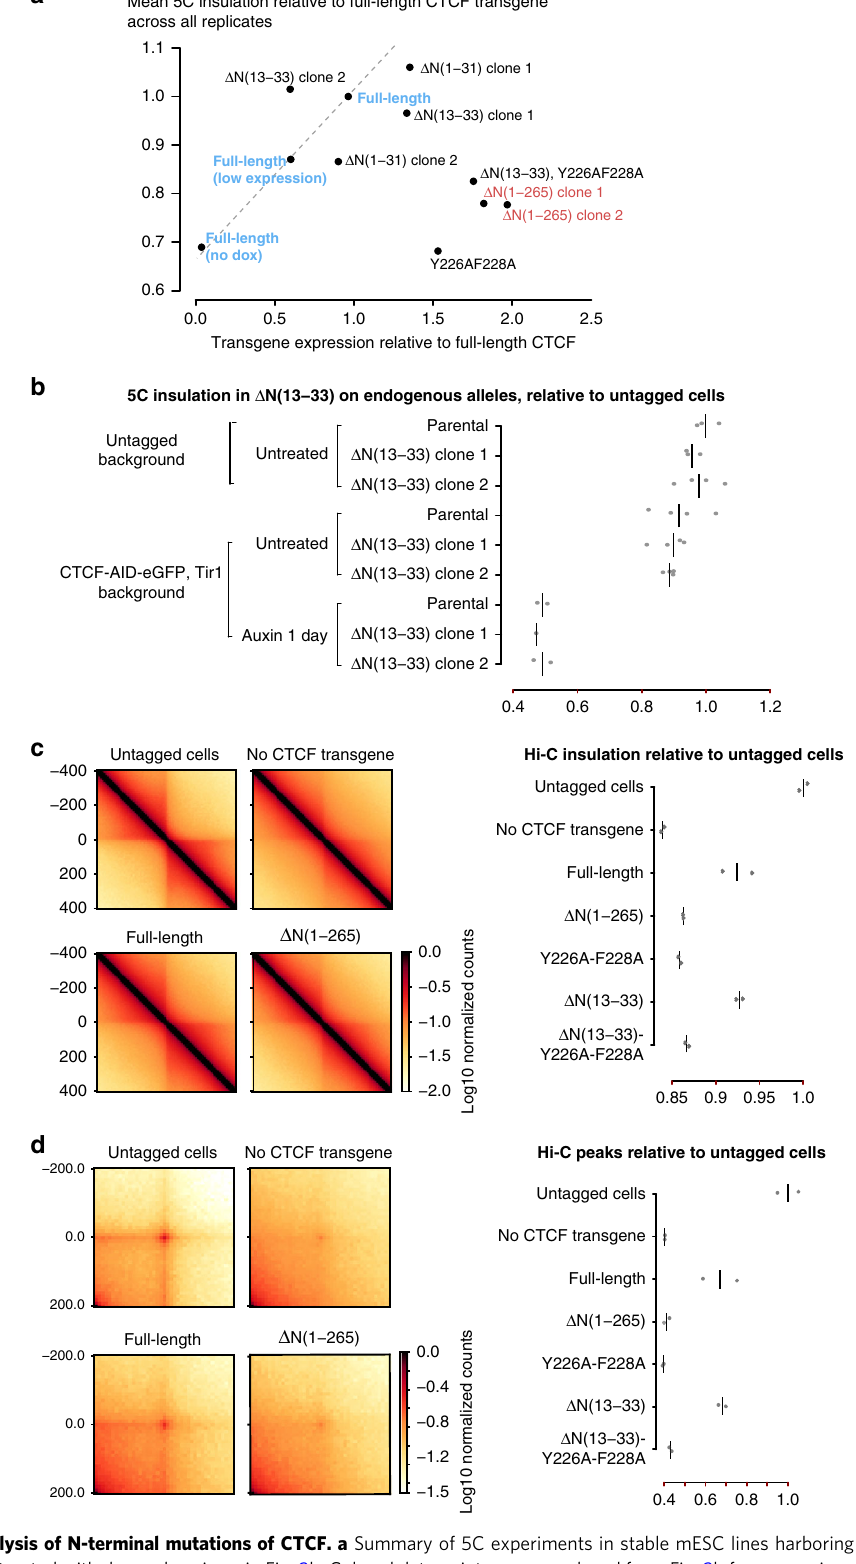
Fig. 5 5C and Hi – C analysis of N-terminal mutations of CTCF. a Summary of 5C experiments in stable mESC lines harboring CTCF transgenes with N- terminal mutations and treated with dox and auxin as in Fig. 2b. Colored data points are reproduced from Fig. 2b for comparison. b TAD insulation analysis from 5C data obtained on cells with region N(13 – 33) from endogenous CTCF alleles. Each point is the average insulation measured in one 5C replicate and notch marks the median. c Hi – C in stable mESC lines expressing CTCF transgenes. Aggregate insulation scores are depicted next to aggregate heatmaps of select genotypes. Each point is the average insulation measured in one Hi – C replicate and notch marks the average. d Same data as in b for aggregate peak